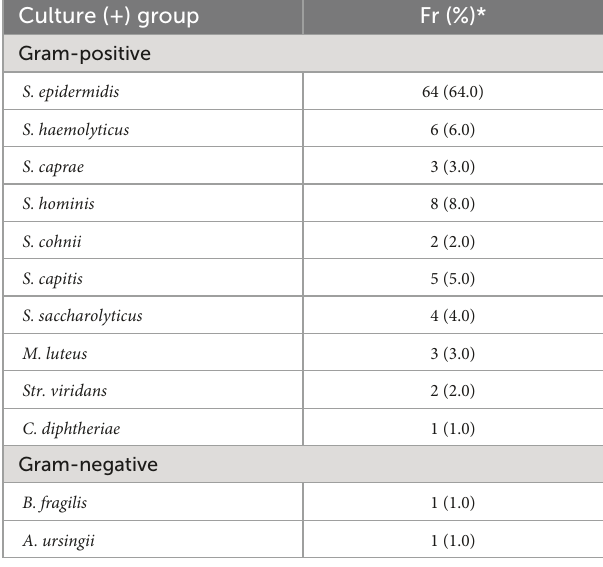
TABLE 3 Bacterial species identified cases of sRBCs culture